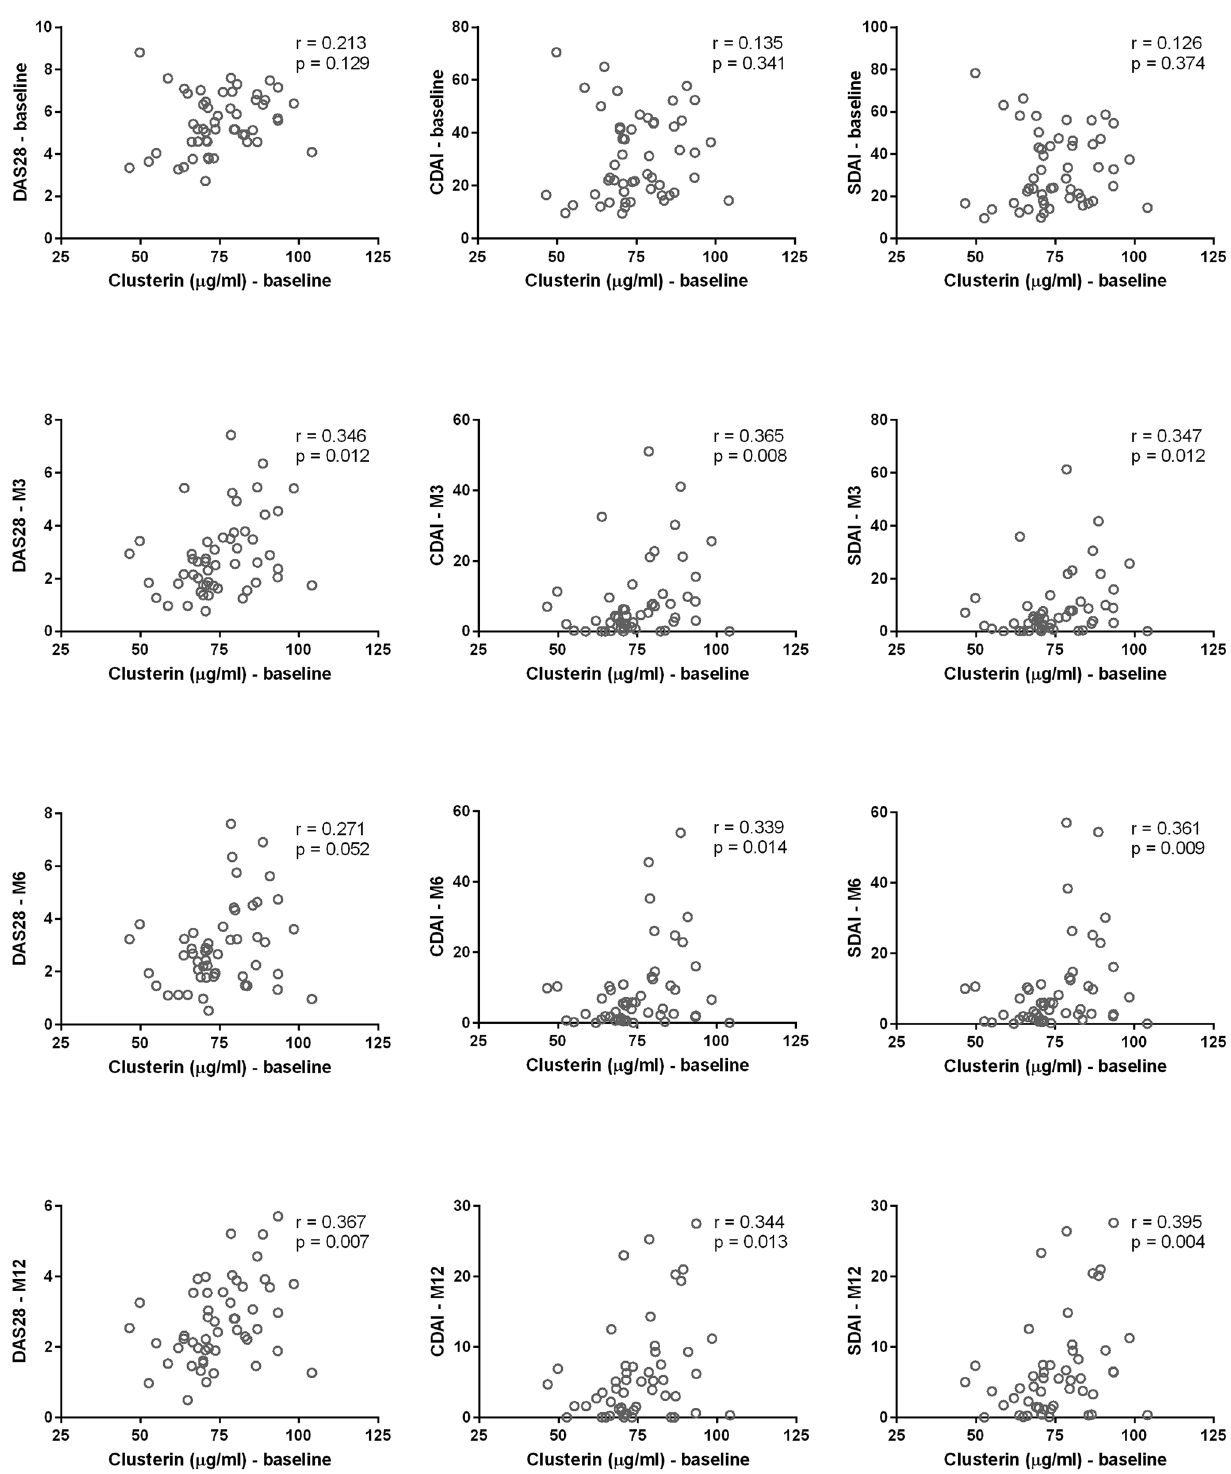
Figure 2. Correlations between baseline clusterin levels and disease activity according to the CDAI, SDAI and DAS28 at baseline and months 3 (M3), 6 (M6) and 12 (M12) after treatment